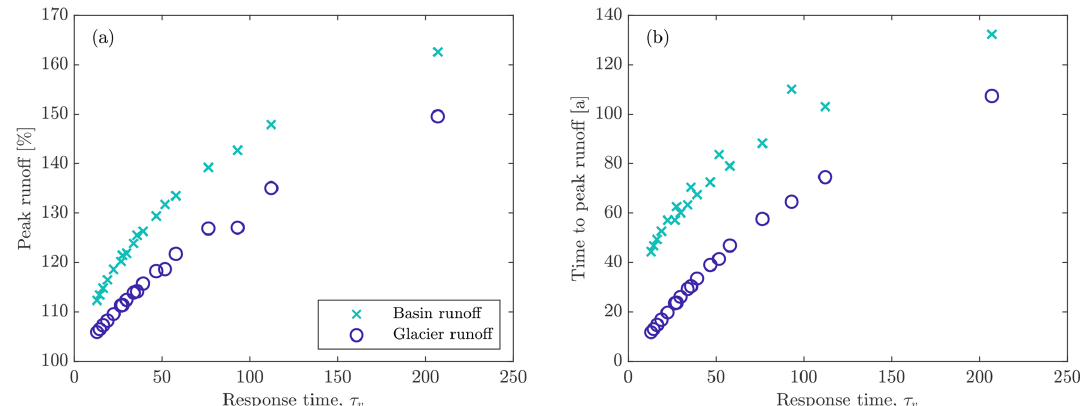
Figure 9. Relationships between glacier response time and (a) peak basin and glacier runoff and (b) time to peak basin and glacier runoff for all simulations that used a rocky landscape (runoff ratio of 1) and the RCP8.5 climate change